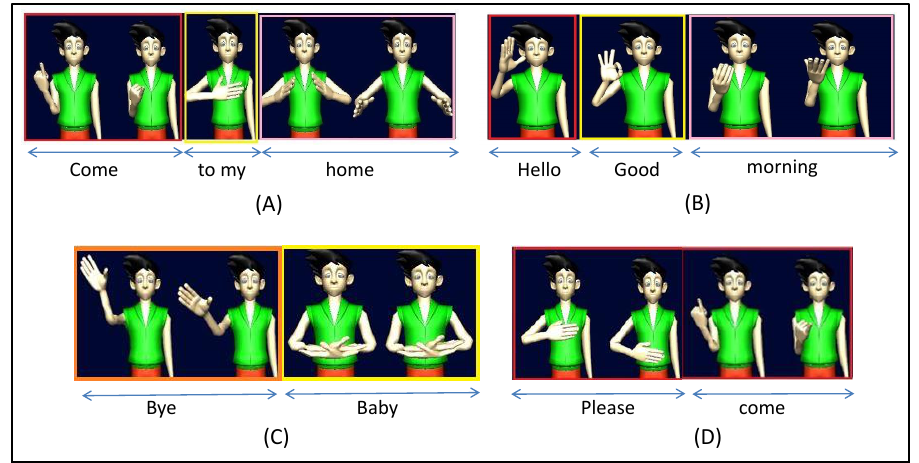
Figure 6. Sign language representations of English sentences: ( A ) Come to my home, ( B ) Hello, good morning, ( C ) Bye baby, ( D ) Please